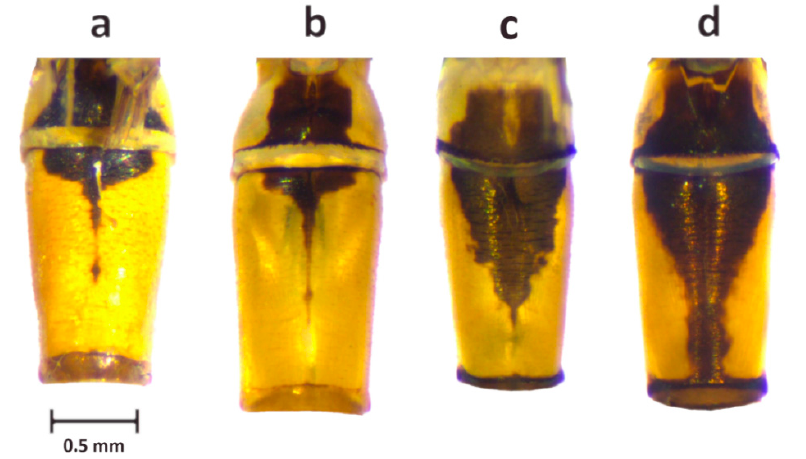
Figure 7. Dorsal view of the first and second abdominal segments of Ischnura rubilio ( a ) and Ischnura aurora from China ( b ), Australia ( c ), and Fiji ( d